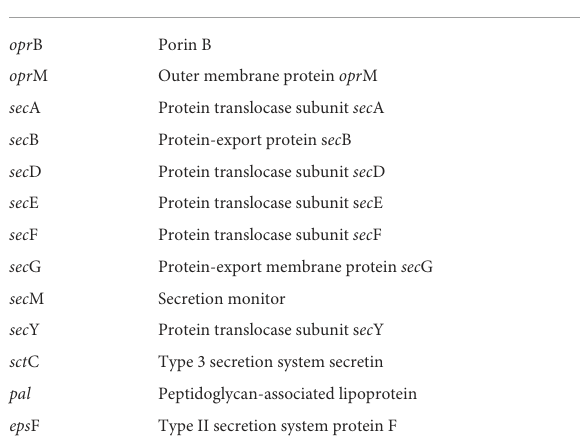
TABLE 6 P. agglomerans strain CPHN2 genomic annotation for chemotaxis, motility, and